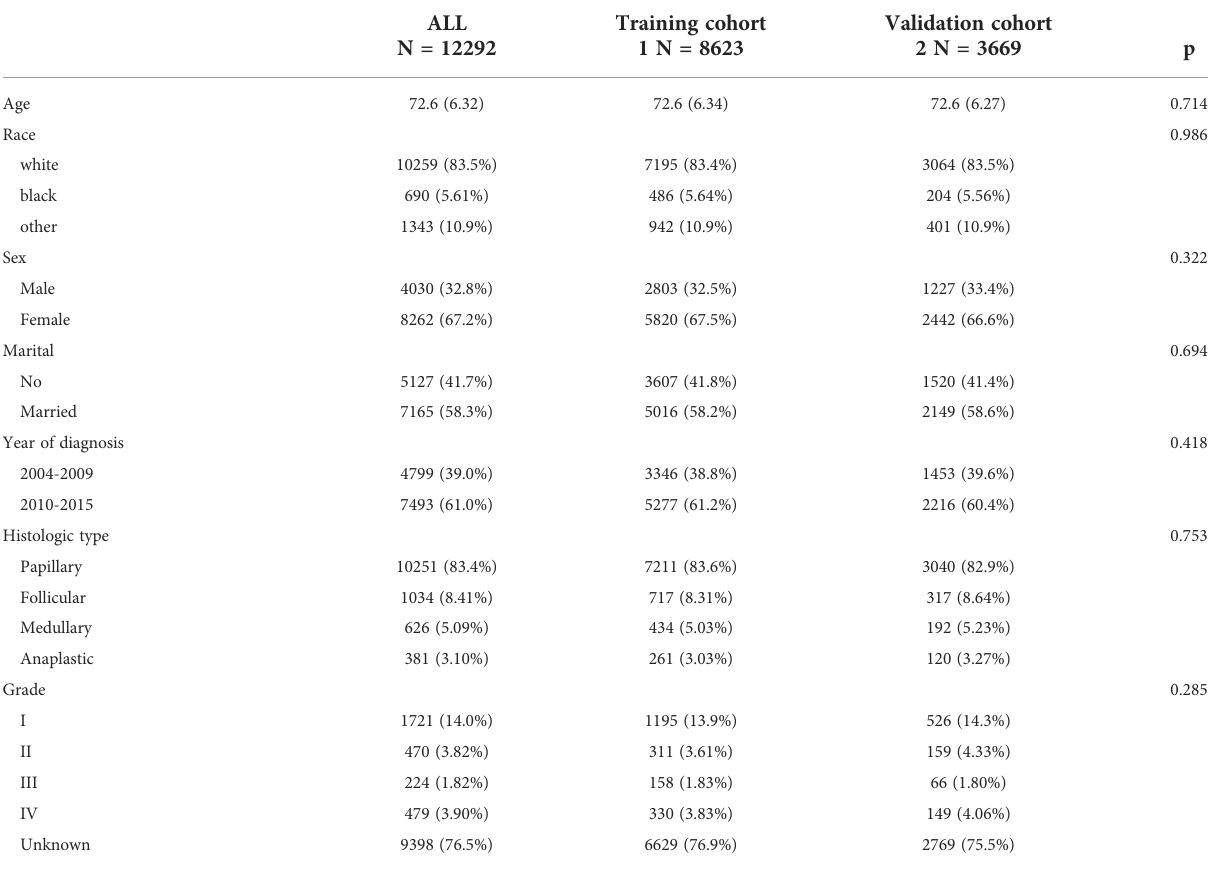
TABLE 1 Clinicopathological characteristics of elderly patients with thyroid